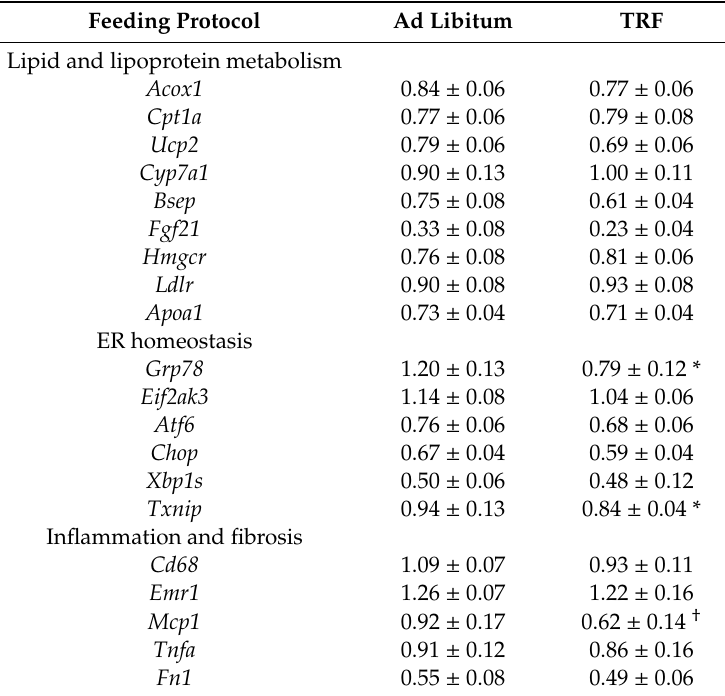
Table 2. Liver tissue gene expression 1 . Feeding Protocol